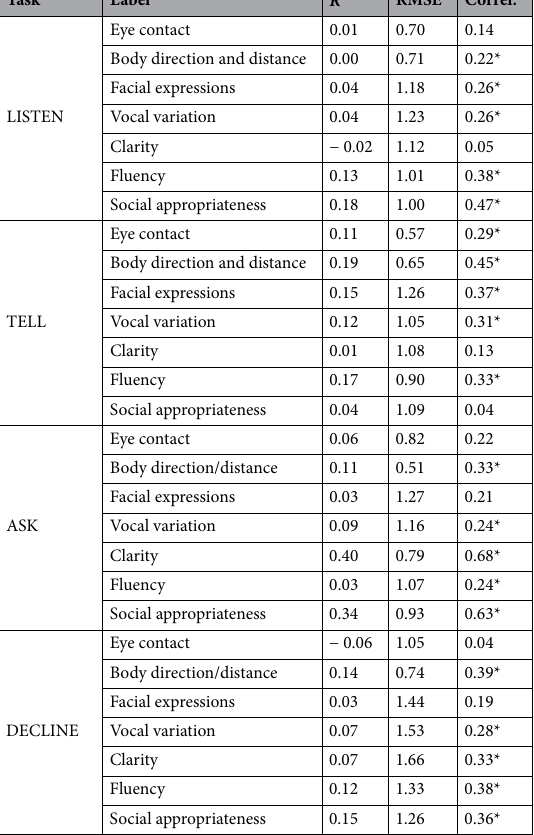
Table 5. Result of social-skill-score estimation: * denotes significant correlation in no-correlation test (p<0.05).